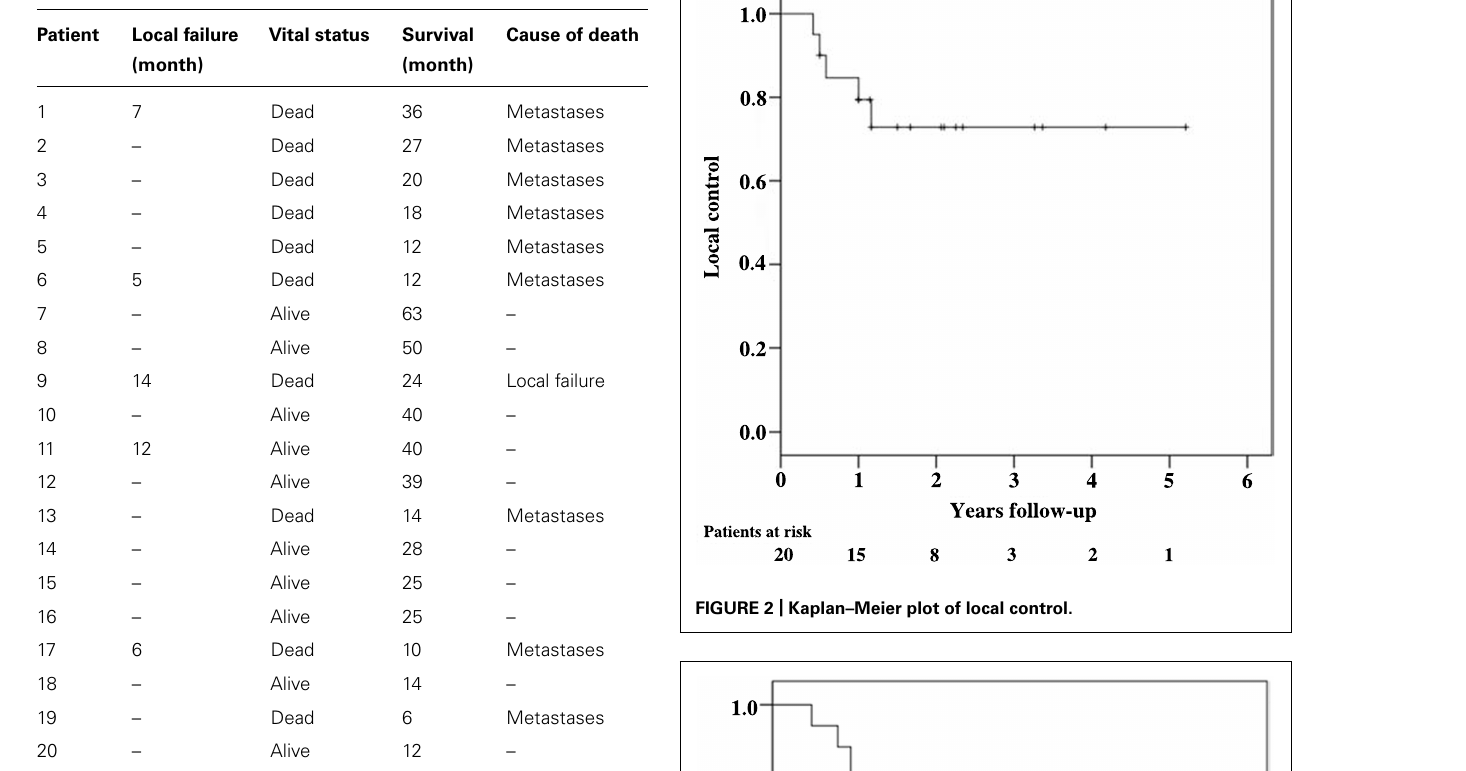
Table 3 | Clinical outcomes.